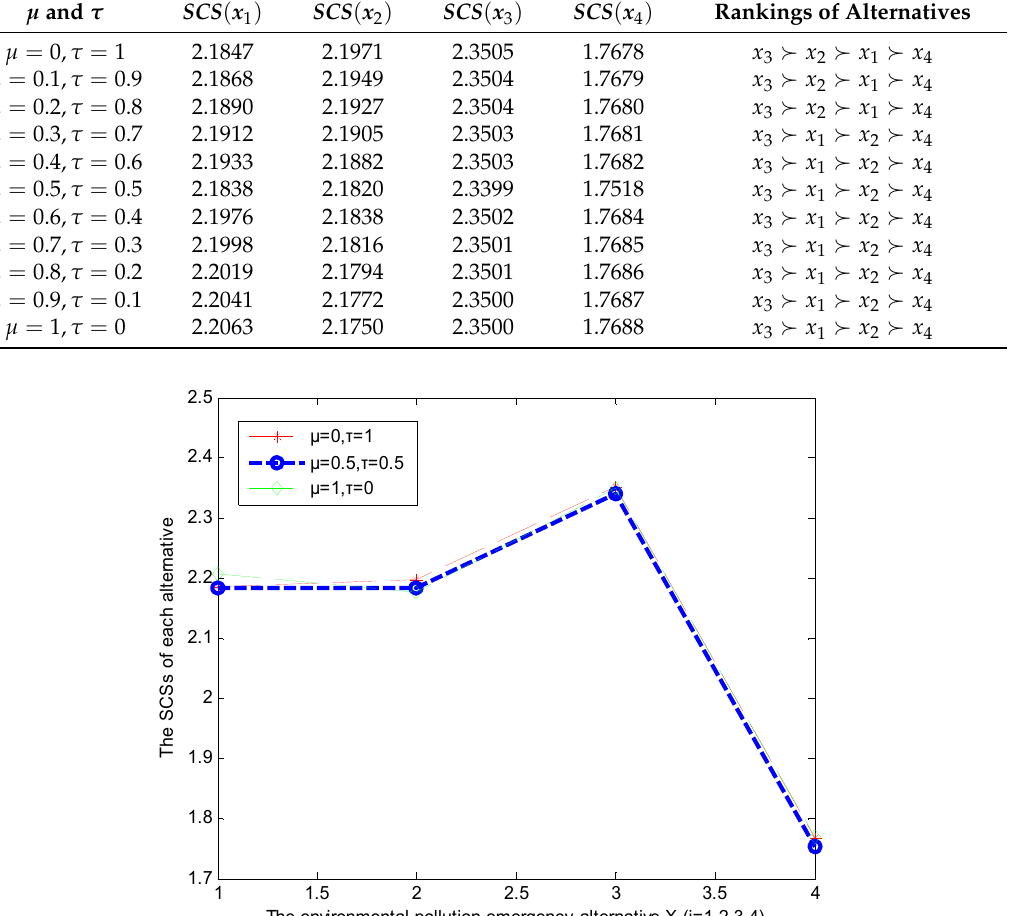
Figure 2. The alternatives ranking with different values of μ and τ .